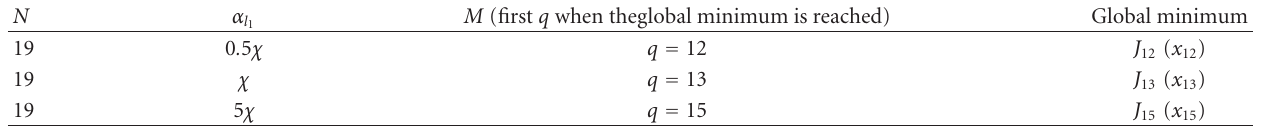
assignments and the first q where the global optimal is reached. Table 10: Simulation results with di ff erent α l 1 N α M (first q when theglobal minimum is reached) Global l 1